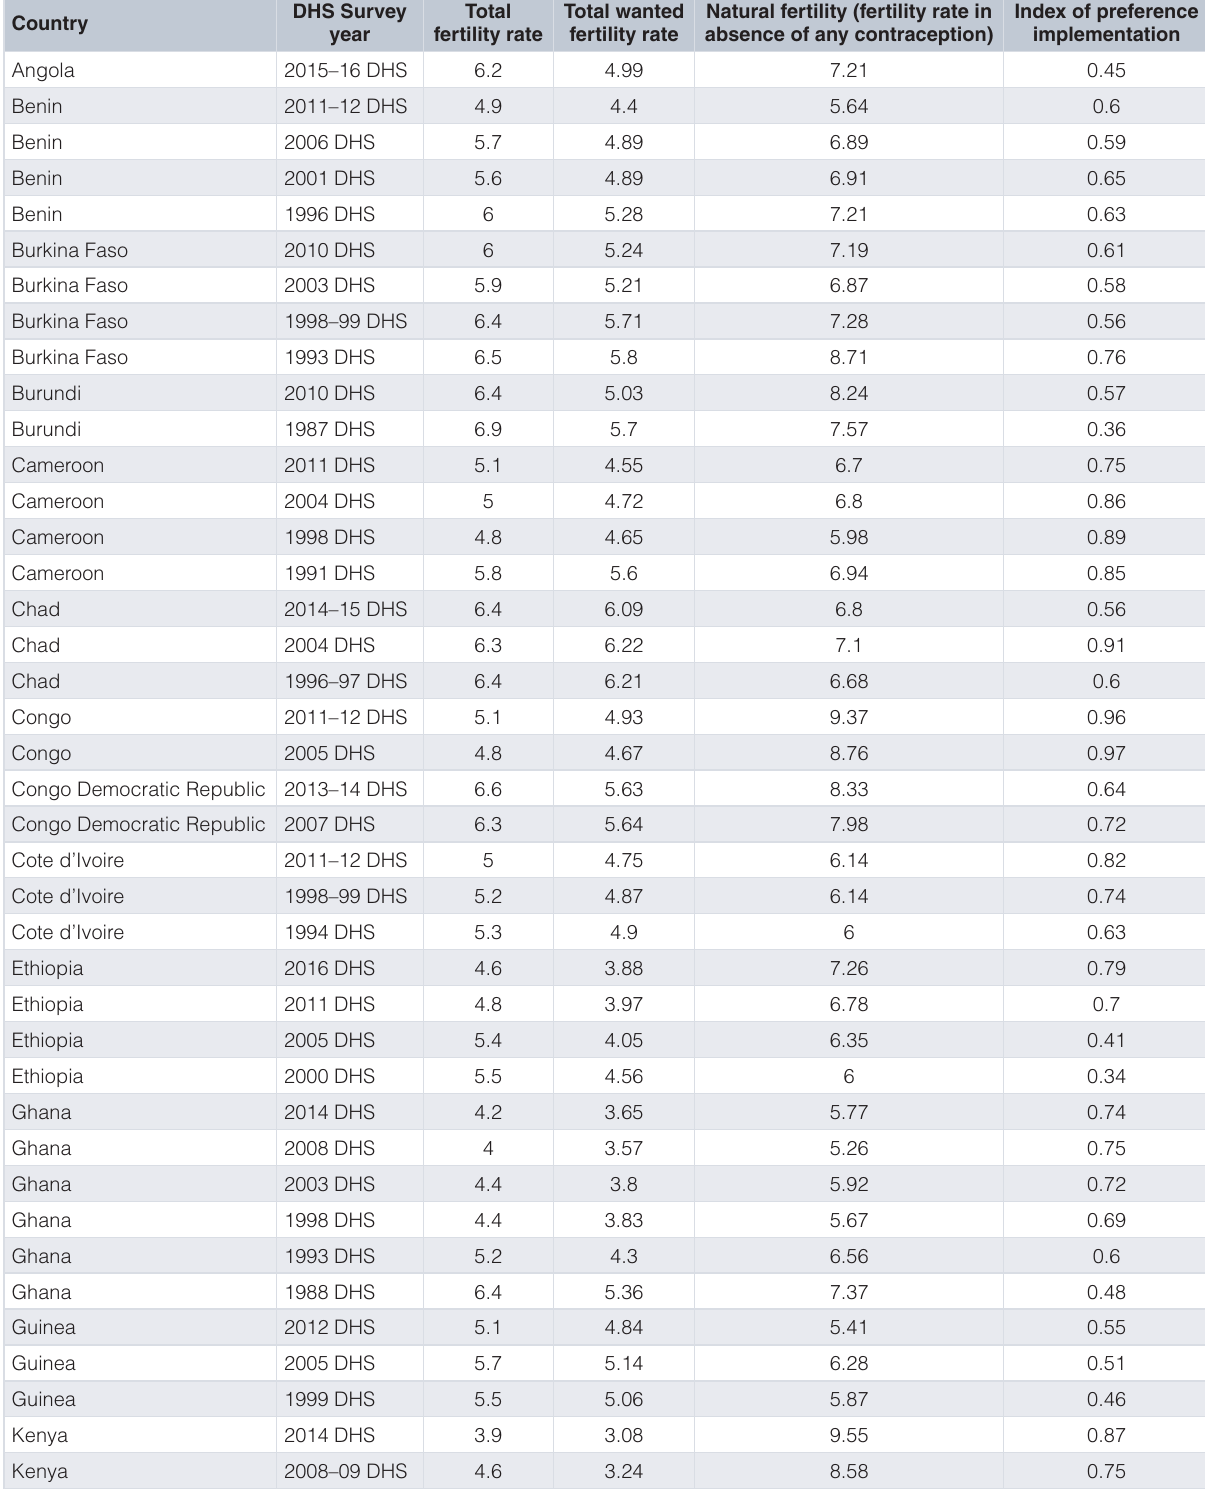
Table 1. Trends in fertility preference estimates of selected Sub-Saharan African countries. Country